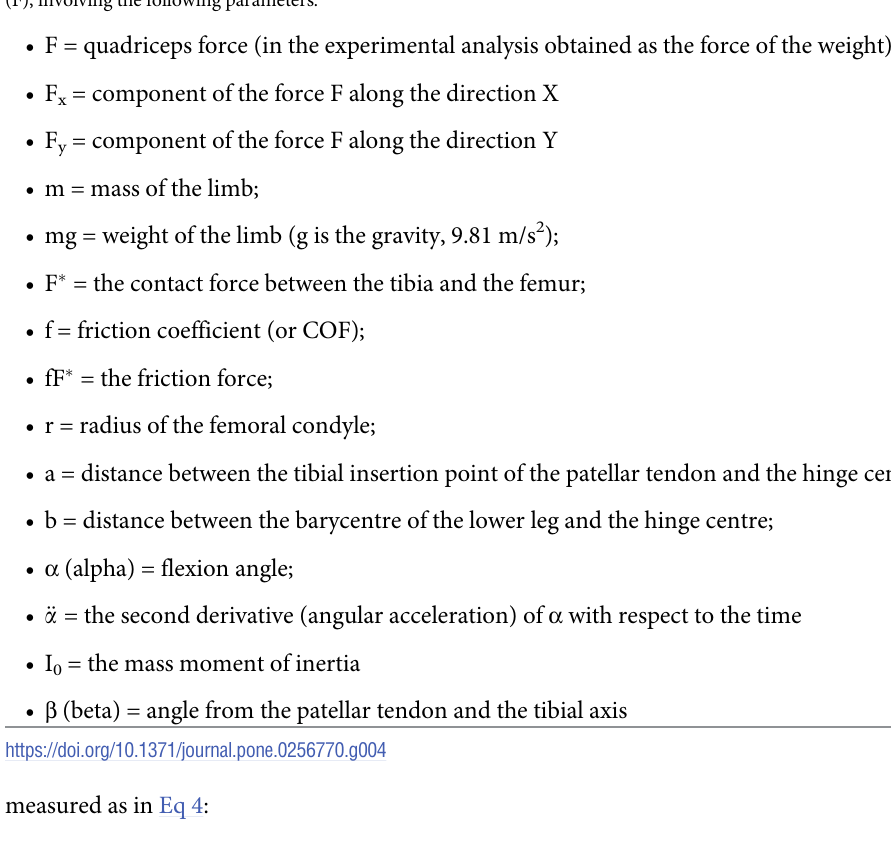
Fig 4. Schematic representation of force involved during the ex-vivo model. Calculations were performed, with the assumption that the ovine hindlimb is a 2D hinge joint that is rotating around the O point, due to the quadriceps force (F), involving the following